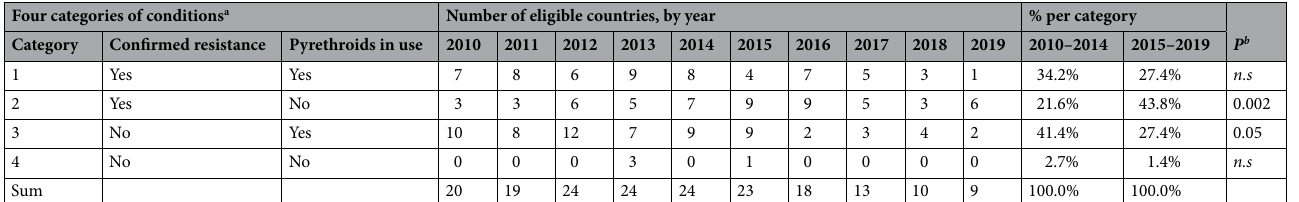
Table 1. Pyrethroid resistance in relation to pyrethroid use per country. Presented is the number of eligible countries in each category per year. ‘Confirmed resistance’ refers to < 90% mortality of anophelines in insecticide susceptibility bioassays for pyrethroids 24 . ‘Pyrethroids in use’ refers to use in IRS for malaria control. a Categories: 1, confirmed resistance, pyrethroids in use; 2, confirmed resistance, no pyrethroids